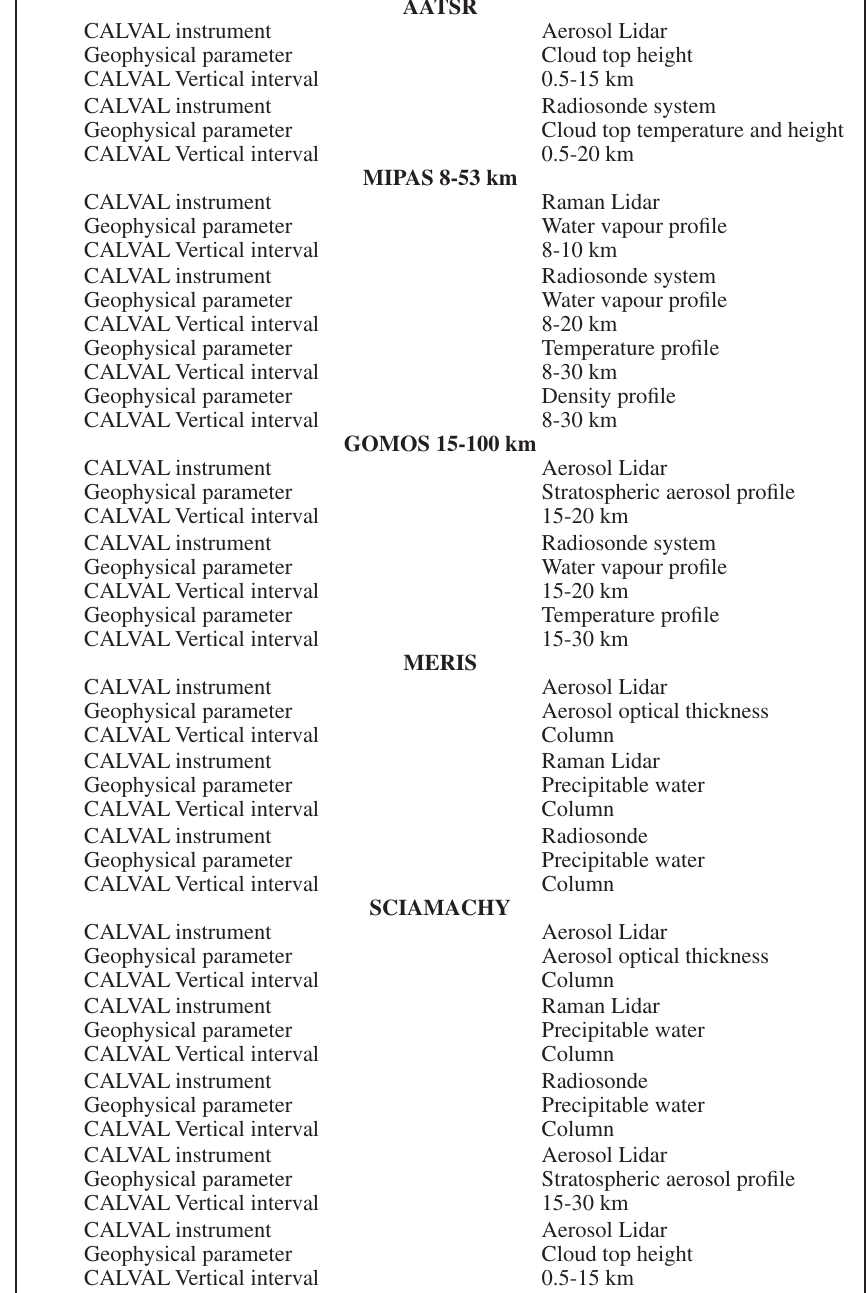
Table I. ENVISAT validation: list of validated and validating